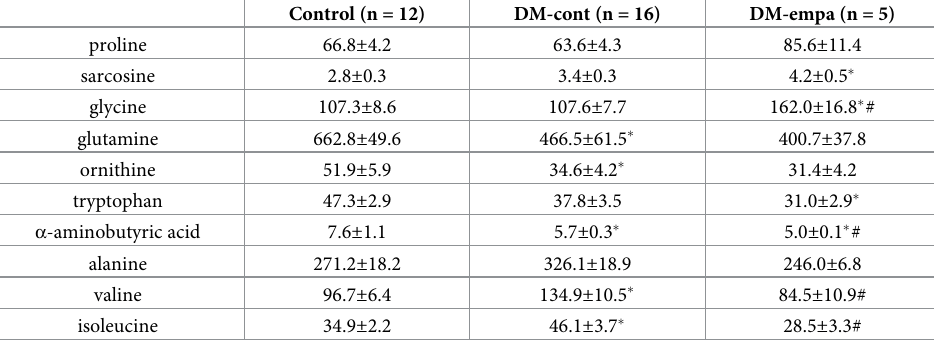
Plasma concentration of amino acids showing VIP values � 1. Data were represented as mean ± SE. � p < 0.05 vs